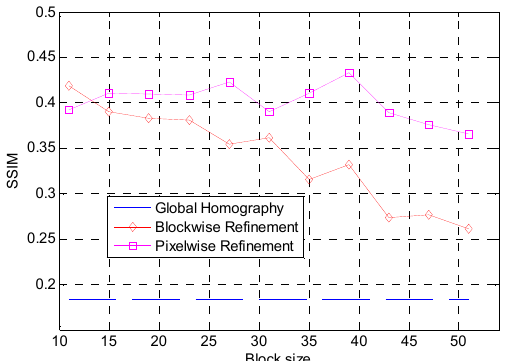
Figure 12. Some examples for the patches before ( a – c ) and after ( d – f ) pixelwise refinement. The artifacts for blockwise mapping are eliminated after pixelwise refinement.